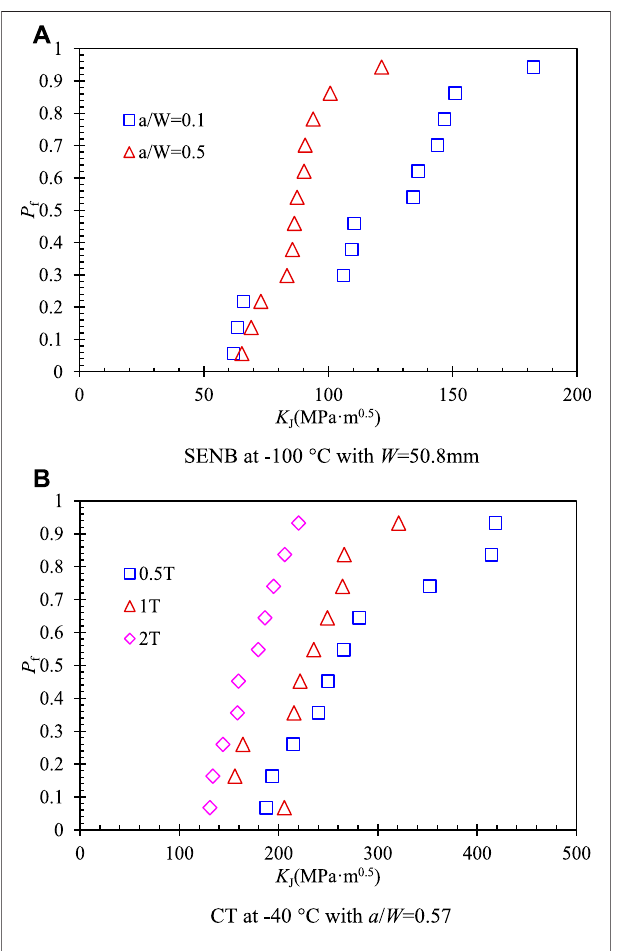
FIGURE 5 | Rank probabilities of fracture toughness data (A) SENB at − 100 ° C with W = 50.8 mm. (B) CT at − 40 ° C with a / W (cid:1) 0 . 57.